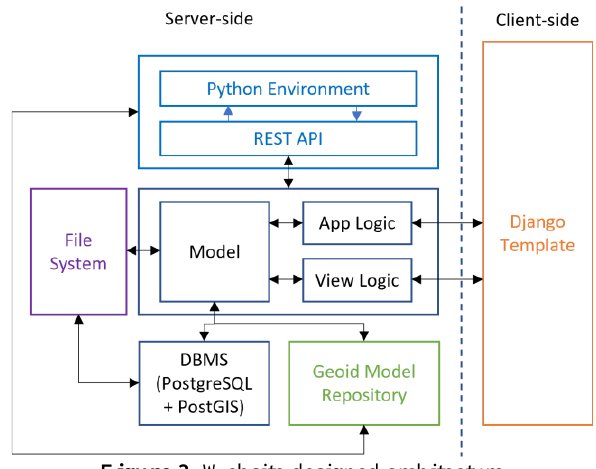
Figure 3. Website designed